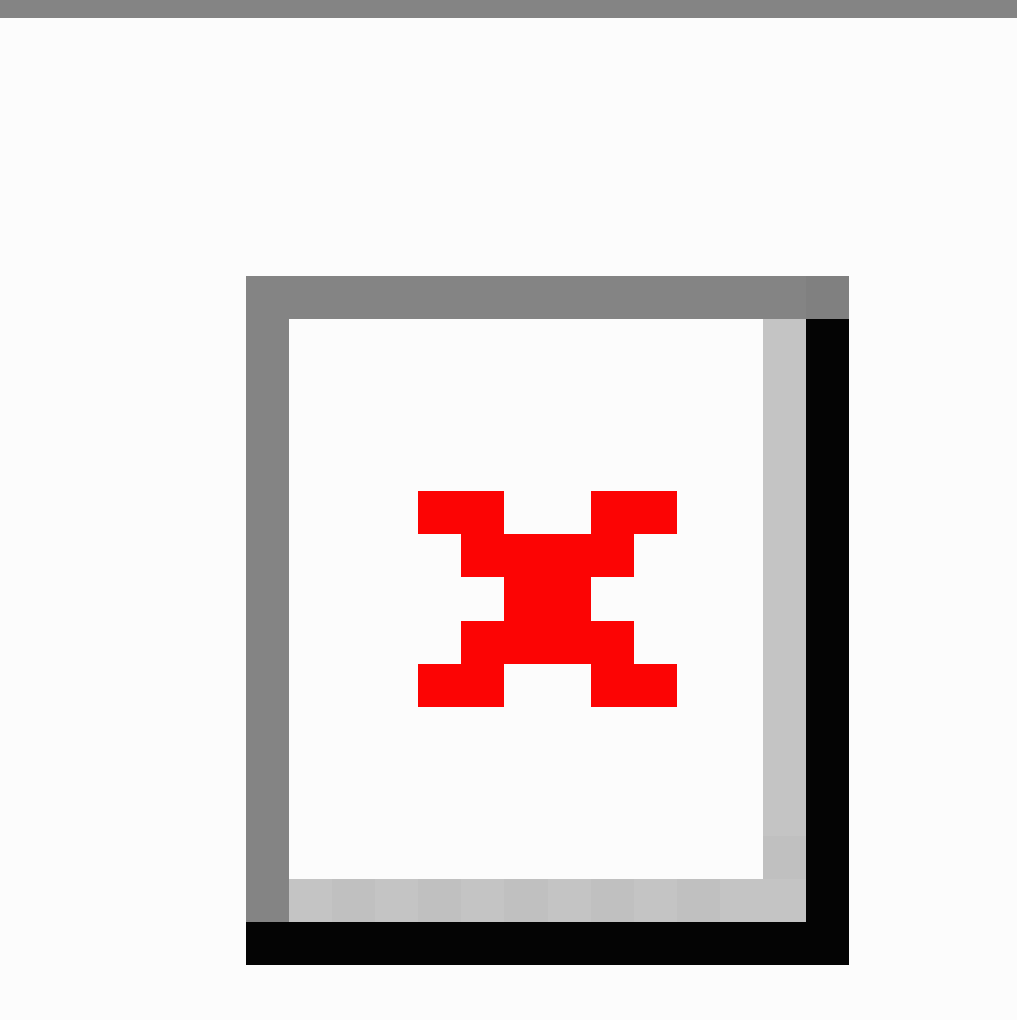
Figure 2. Screenshot of the IPSS Android smartphone application. IPSS: International Prostate Symptom